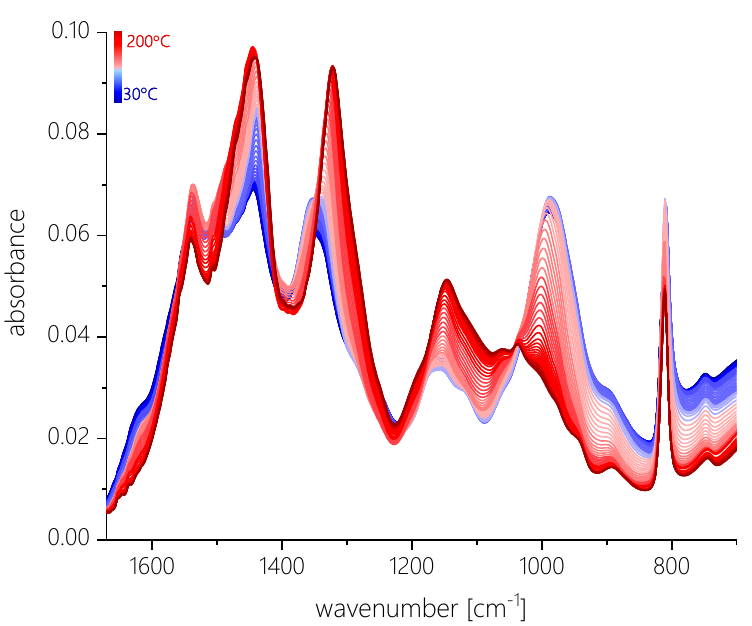
Figure 1. Infra-red spectra recorded during curing of the spray-dried MF-resin system Kauramin ® 773 at a heating rate of 2 °C min − 1 using real-time in-situ FTIR spectroscopy .